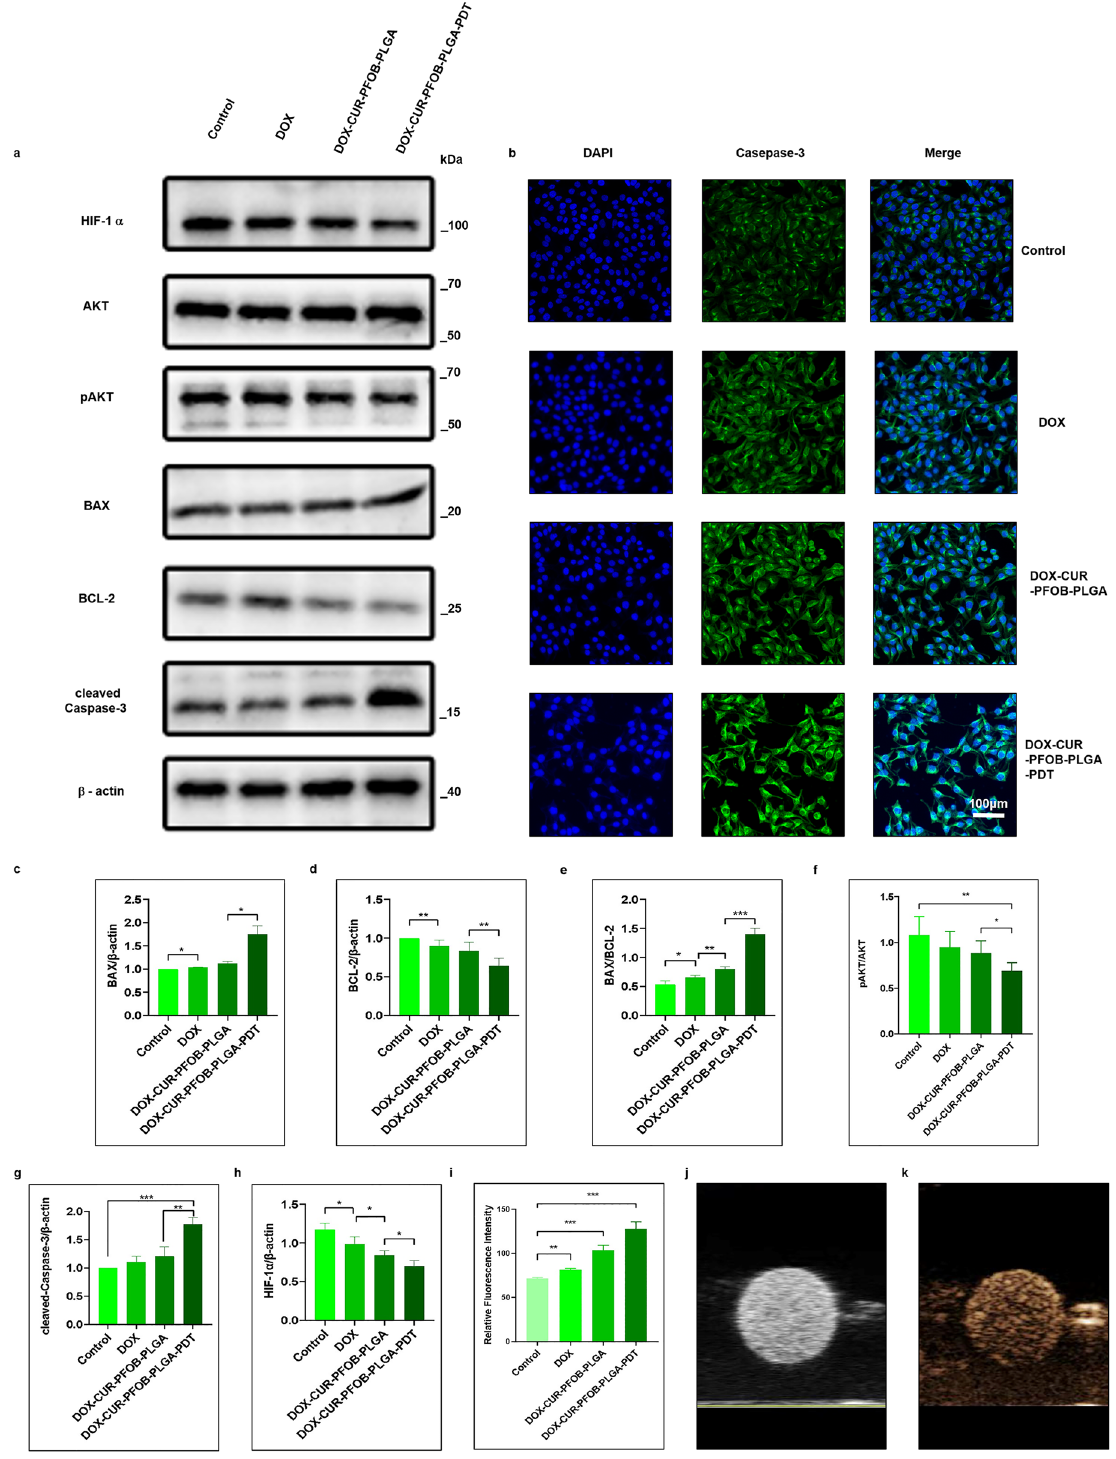
Figure 7. Molecular biology detection of MCF-7 cells and ultrasound imaging of DOX–CUR–PFOB–PLGA NPs by HIFU. ( a ) Western blot detection for HIF-1α, AKT, p-AKT, BAX, BCL-2, cleaved Caspase-3 and β-actin protein expressions, The full-length gels of all cropped blots combined are shown in Supplementary Figure S1; ( b ) The effects of DOX–CUR–PFOB–PLGA NPs on the expression of Caspase-3 (green) in MCF-7 cells incorporated with DOX, DOX–CUR–PFOB–PLGA or DOX–CUR–PFOB–PLGA and PDT, The nucleus was counterstained with DAPI (blue). (c) Quantitative analysis of the expression of BAX/β-actin; ( d ) Quantitative analysis of the expression of BCL-2/β-actin; (e) Quantitative analysis of the expression of BAX/BCL-2; ( f ) Quantitative analysis of the expression of pAKT/AKT; ( g ) Quantitative analysis of the expression of cleaved Caspase-3/β-actin; ( h ) Quantitative analysis of the expression of HIF-1α/β-actin. ( i ) Quantitative analysis of the relative fluorescence intensity of Caspase-3; ( j ) The B-mode image of DOX–CUR–PFOB–PLGA NPs by ultrasonic diagnostic apparatus; ( k ) The imaging mode image of DOX–CUR–PFOB–PLGA NPs by ultrasonic diagnostic apparatus. The expression of the proteins was quantified by Image J 1.46 r (https:// imagej. nih. gov/ ij/ docs/ guide/ 146. html) and Graphpad Prism 8.0 (https:// www. graph pad. com/ updat es), * P < 0.05; ** P < 0.01; *** P <